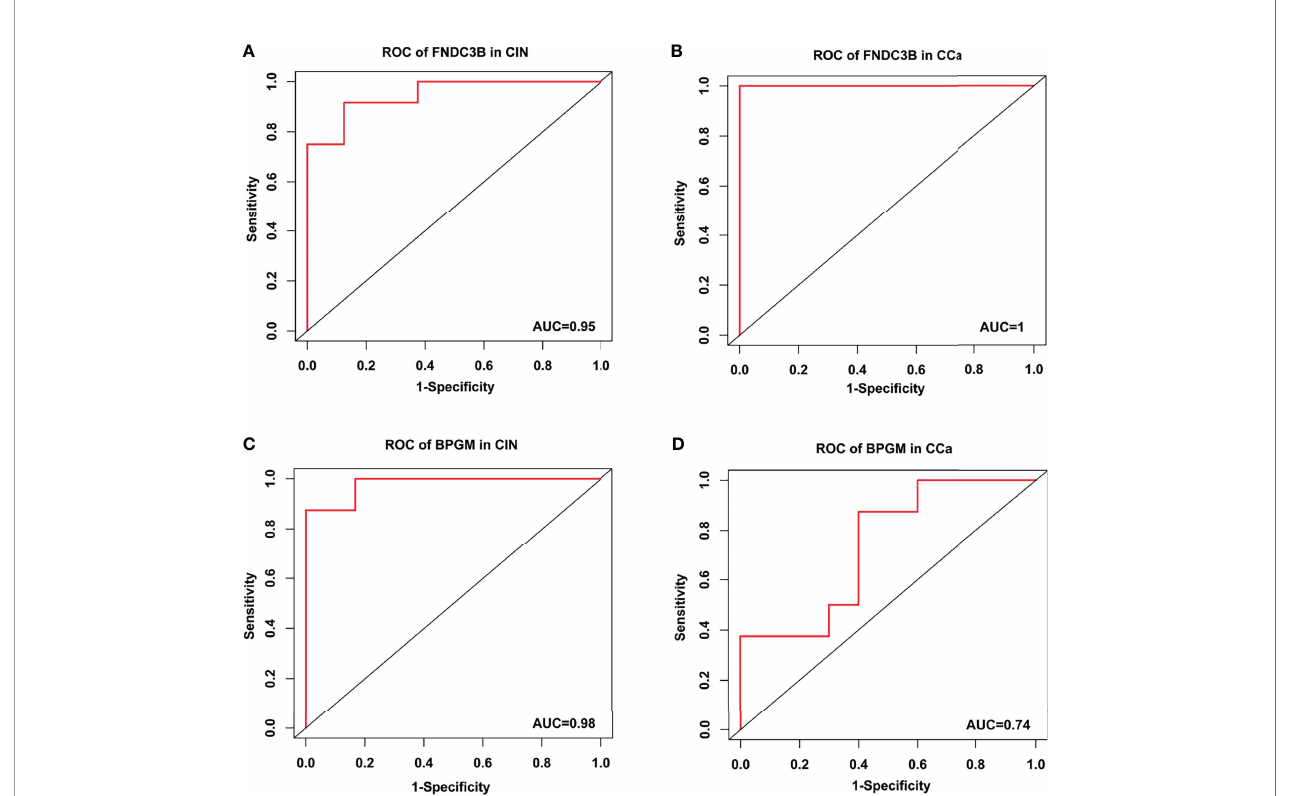
FIGURE 8 | Receiver operating characteristic curve analysis in CIN and CCa. (A) ROC of FNDC3B in CIN. (B) ROC of FNDC3B in CCa. (C) ROC of BPGM in CIN. (D) ROC of BPGM in